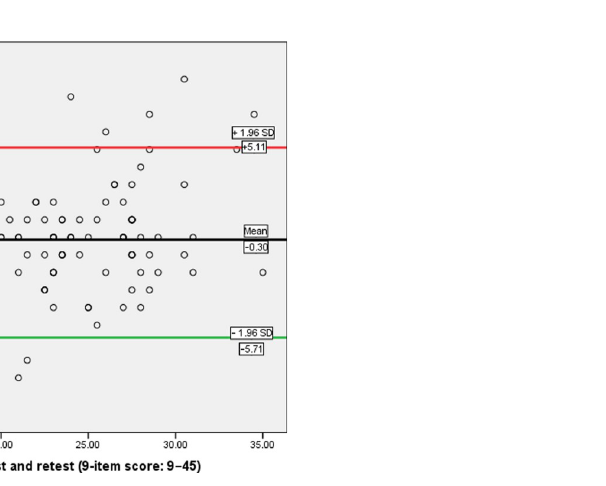
Fig 1. Bland-Altman plot for test-retest agreement of